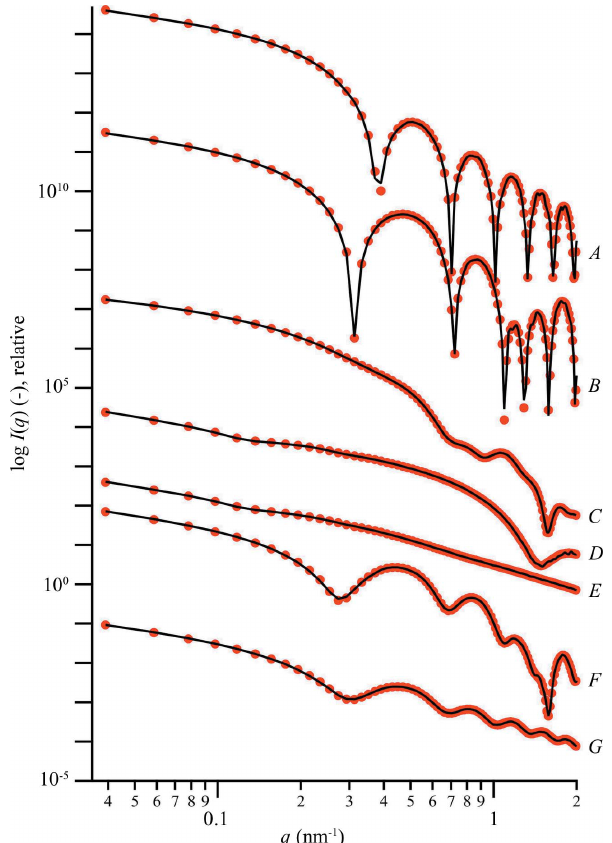
Figure 2 Scattering curves computed from the seemingly endless model geome- tries A – G shown in Fig. 3 (red circles; see Appendix A for model details) and fits from the reconstruction (black lines). For better visualization, the scattering patterns are shifted vertically and error bars have been omitted (see Fig. S14 for high- q magnifications of these